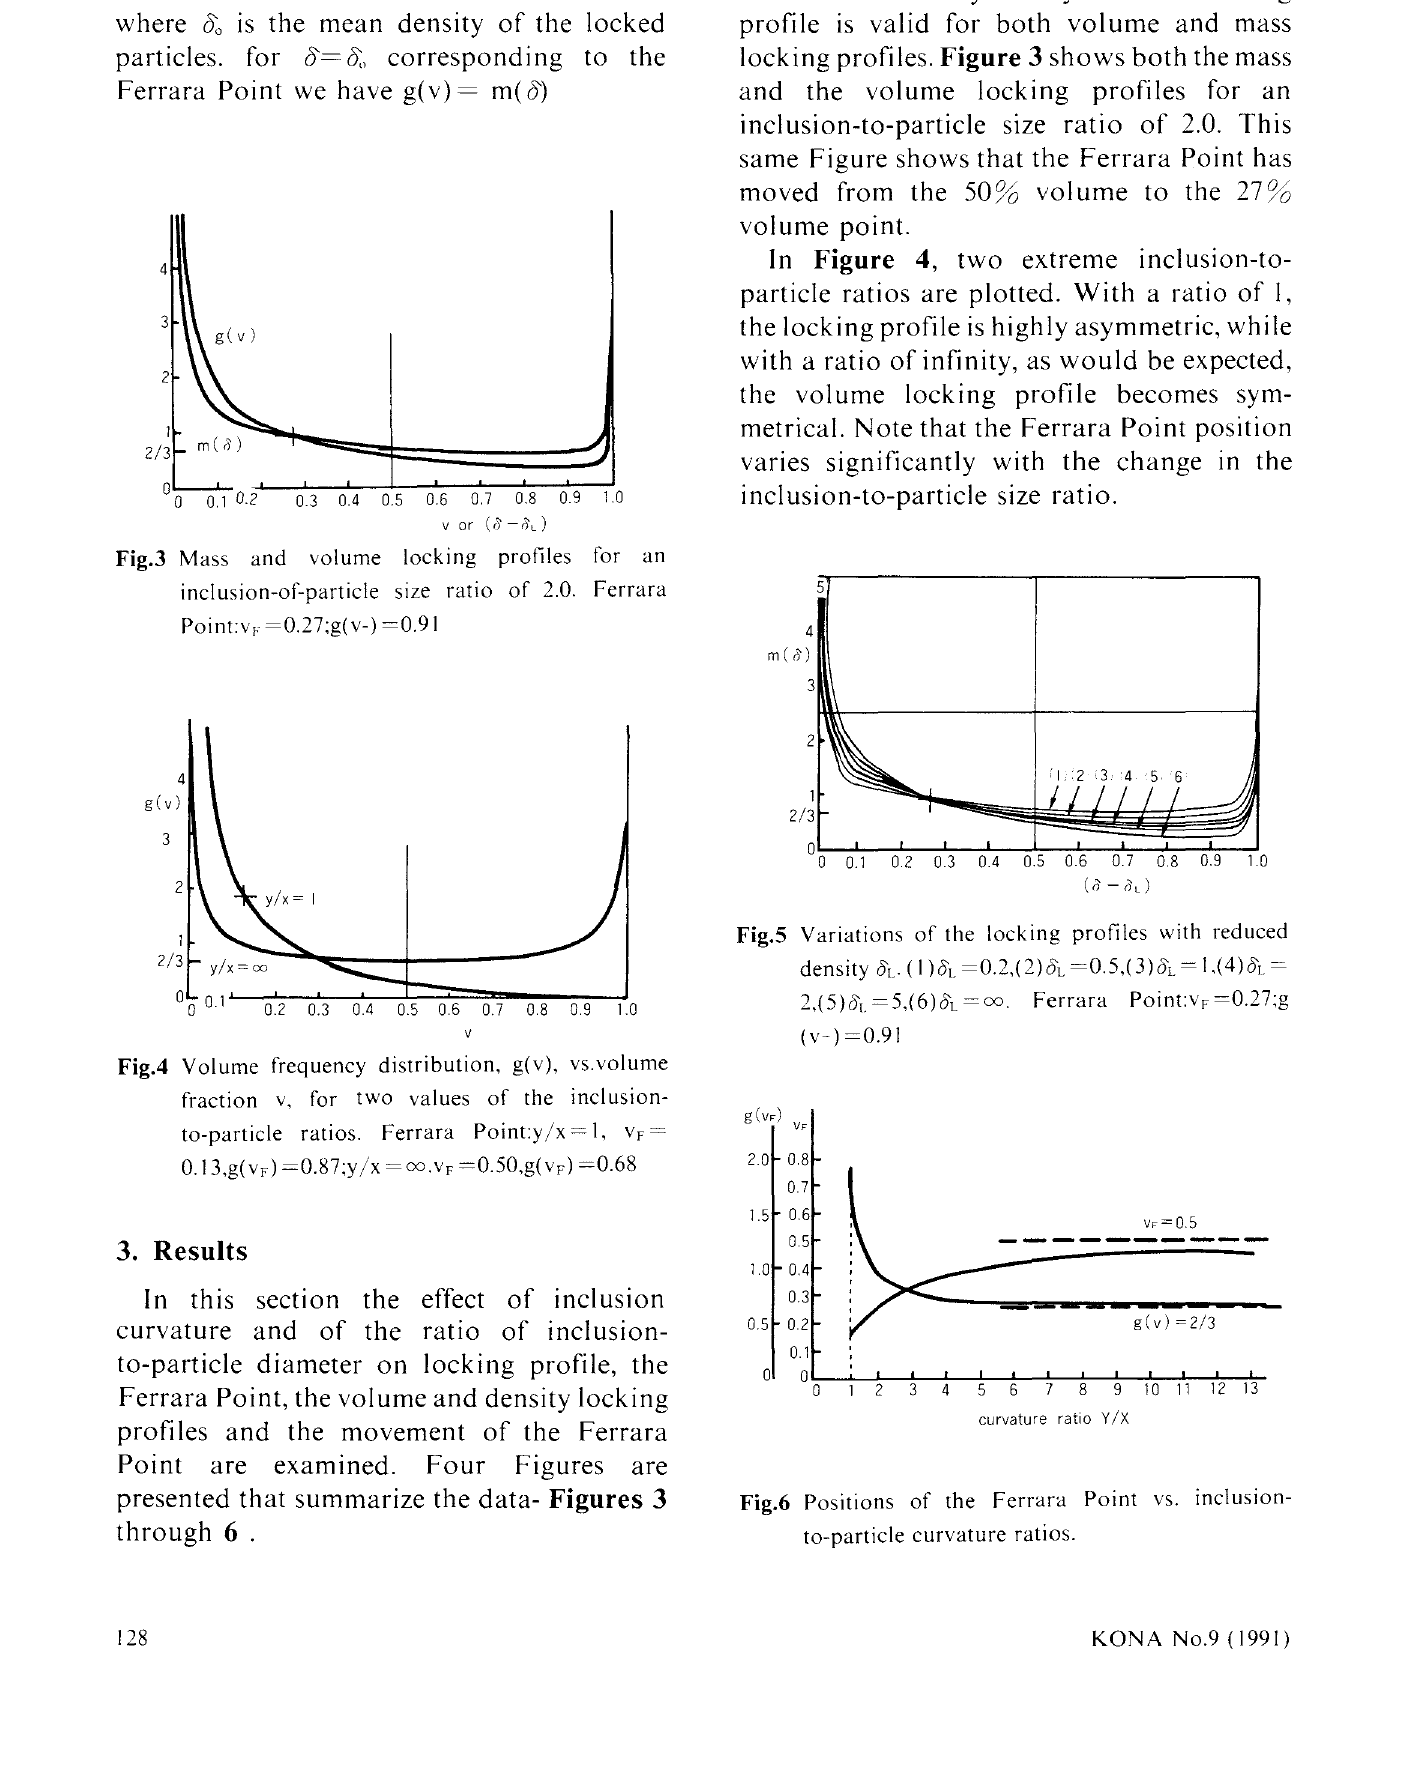
Fig.6 Positions of the Ferrara Point vs. inclusion to-particle curvature